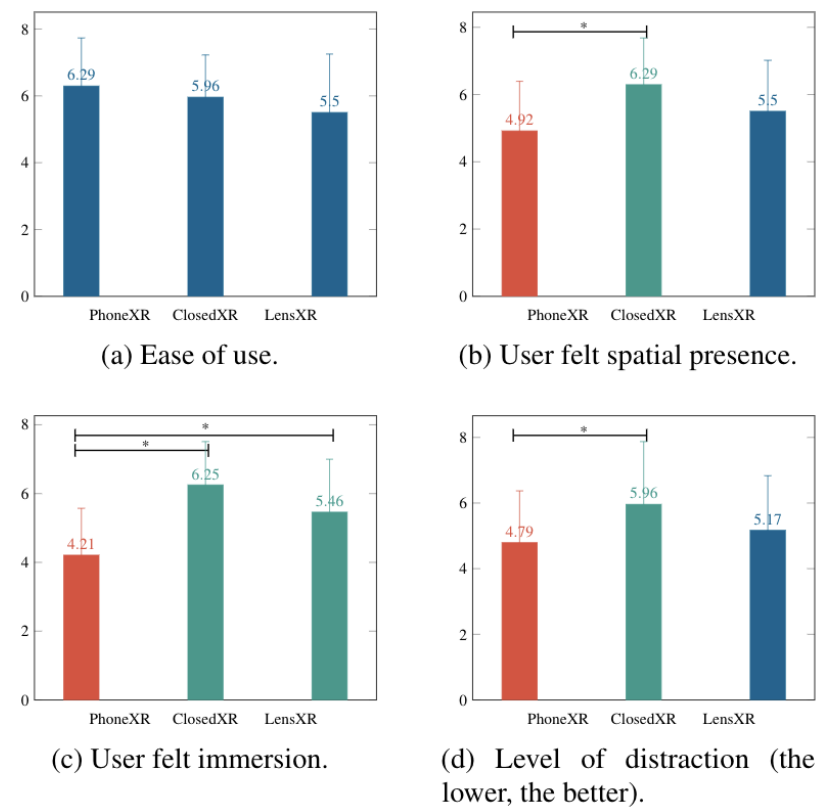
Figure 8. Survey results regarding the UX for VR mode operation—statistical differences are indicated with the “*” mark and illustrated by color grouping. The vertical axes represent the subjective levels in the 7-point Likert scale.